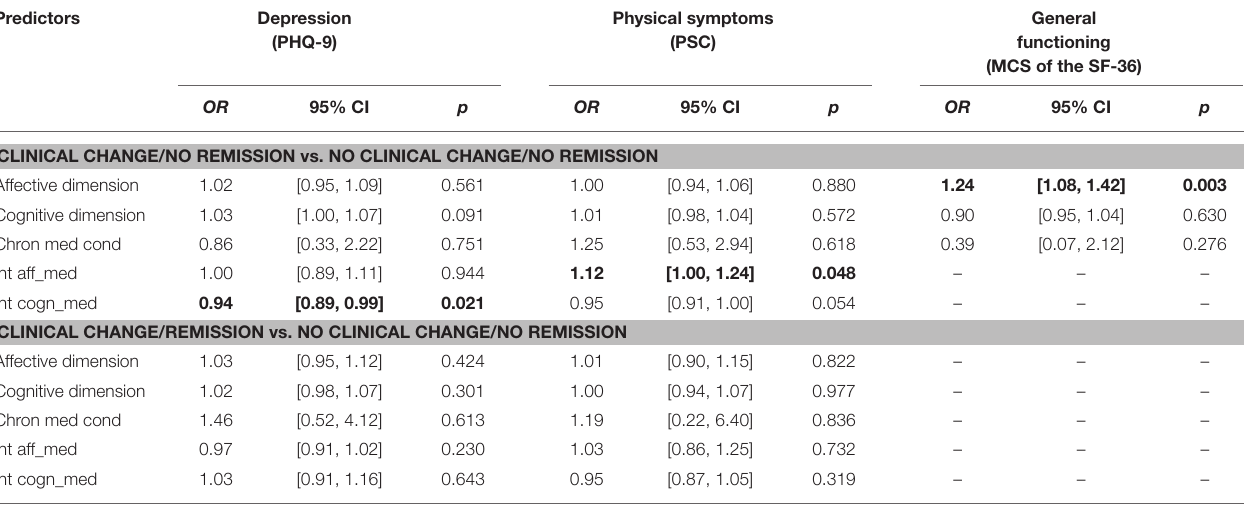
TABLE 5 | Multinomial logistic regression analyses predicting clinical change regarding depression, physical symptoms, and general functioning.